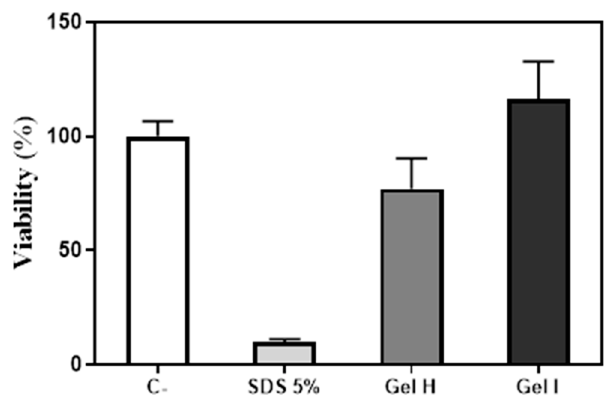
Figure 7. MTT assay on GTE after the application of periodontal gels and LPS for 72 h. Negative control (C − ) was obtained from culture media of GTE treated with PBS that was set at 100%. Positive control (SDS 5%) was obtained from culture media of GTE treated with 10% SDS diluted in PBS (1:1). Values represent the mean ± SEM ( n = 3). Results were statistically compared by Kruskal-Wallis.